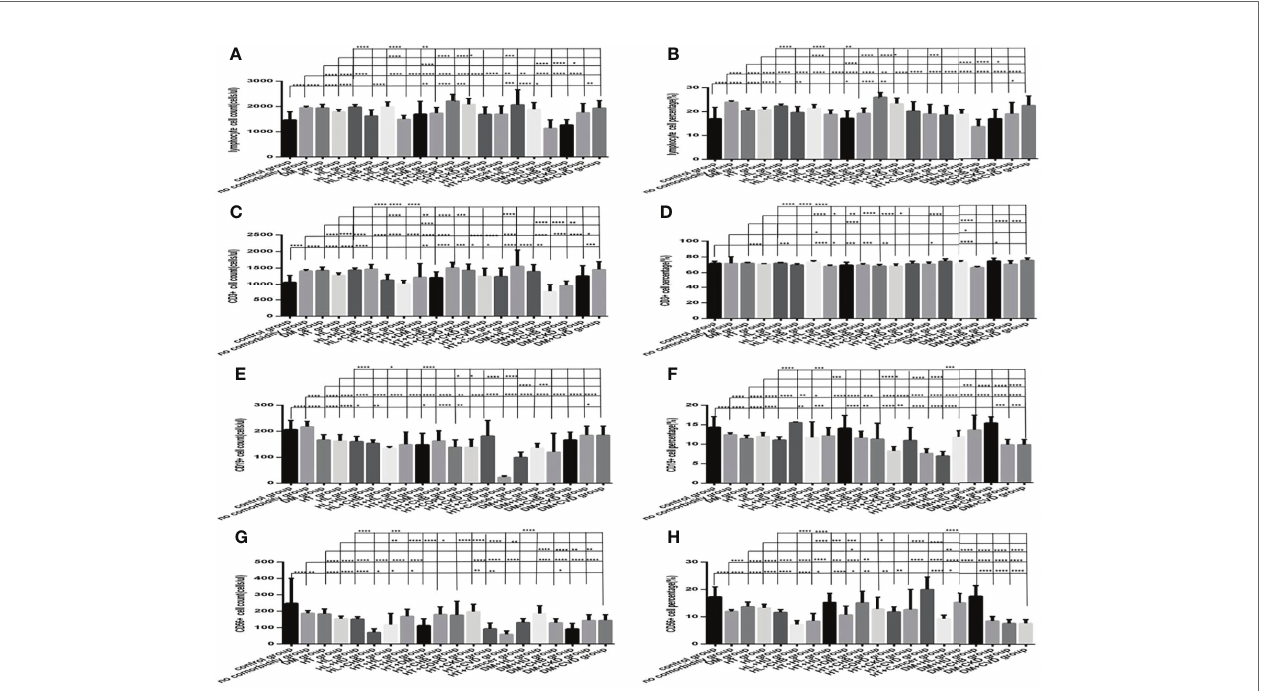
FIGURE 12 | Comparison of lymphocyte, T, B and NK cell subset counts and percentages among the control group, the no comorbidity group, with DM group, with hypertension group, with hyperlipidemia group, and with each combination of DM, or hypertension, or hyperlipidemia and other comorbidities group ( n =773; control, no comorbidity, DM, hypertension, hyperlipidemia and each combination of DM, or hypertension, or hyperlipidemia and other comorbidities group, n =55, 253, 63, 82, 133, 16, 10, 23, 6, 19, 8, 5, 9, 7, 5, 23, 6, 5, 5 and 5 cases, respectively). CHB, chronic hepatitis B.CKD, chronic kidney disease. COPD, chronic obstructive pulmonary disease. COVID-19, coronavirus disease 2019.CVD, cardiovascular disease. NAFLD, nonalcoholic fatty liver disease. DM, diabetes mellitus. HT, Hypertention. HL, heperlipidemia. HU, hyperuricemia and gout. (A) lymphocyte count. (B) lymphocyte percentage. (C) CD3+ count. (D) CD3+ percentage. (E) CD19+ count. (F) CD19+ percentage. (G) CD56+ count. (H) CD56+ percentage. Unpaired one-way ANOVA was used for intergroup comparisons ( A – C, E – H , P all < 0.0001; D , P all < 0.001). Unpaired t -tests were used for comparisons with the control group, and with the no comorbidity group, with DM group, with hypertension group, with hyperlipidemia group, * P < 0.05, ** P < 0.01, *** P < 0.001, **** P <